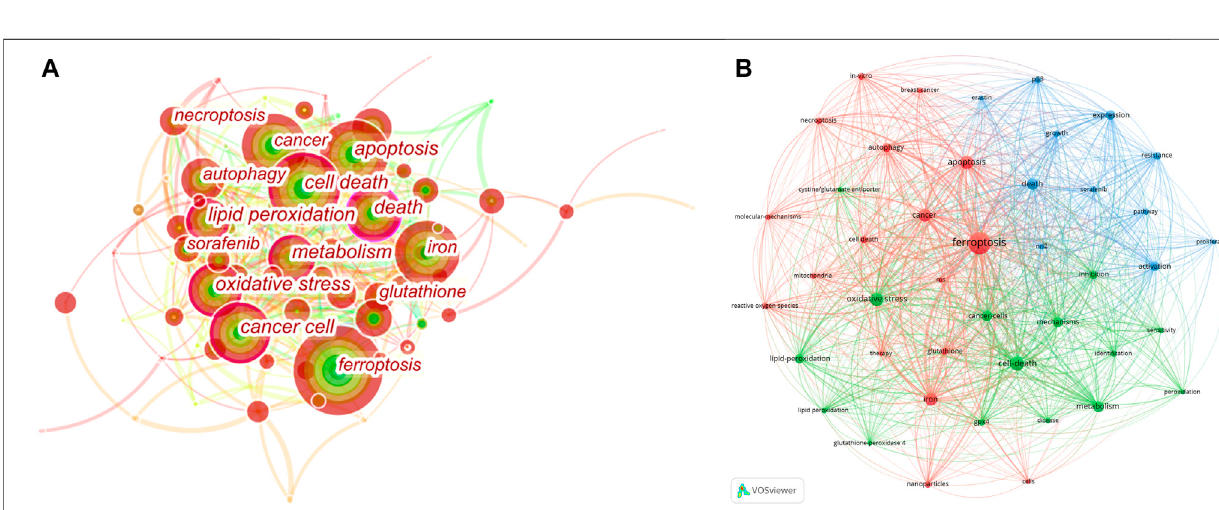
Frontiers in Cell and Developmental Biology |